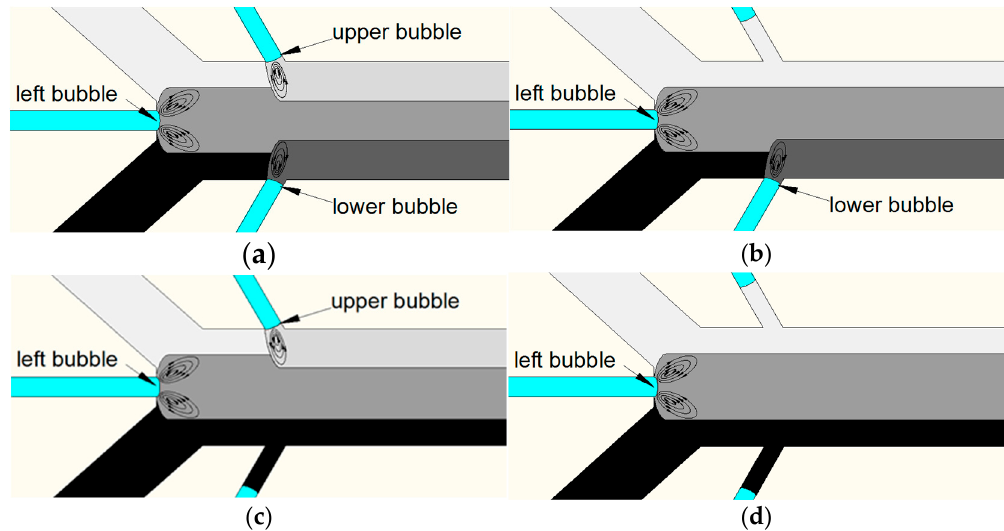
Figure 2. Schematic of the gradient tunable generator’s working process. ( a ) Concentration gradients with three oscillating bubbles mixing. ( b ) Concentration gradients with mixing of the left bubble and lower bubble. ( c ) Concentration gradients with mixing of the left bubble and upper bubble. ( d ) Concentration gradients with left bubble mixing.